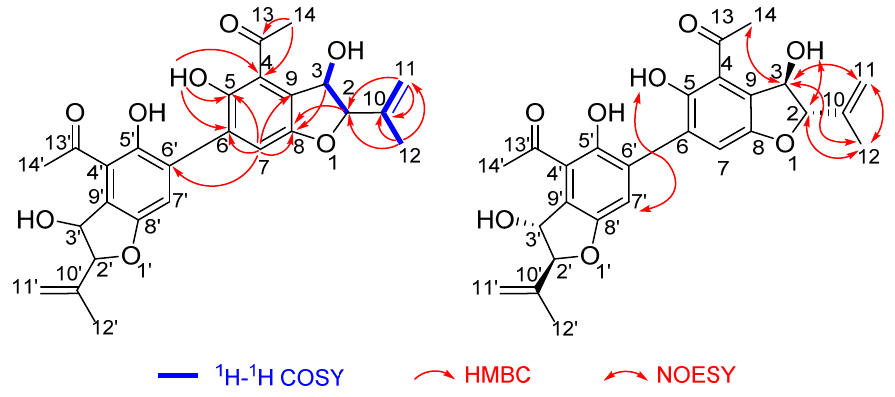
Figure 1. Key 2D NMR correlations for 1 .